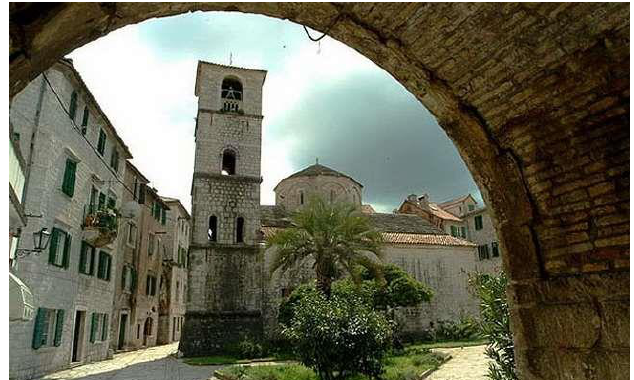
Figure 7. The Church of St. Mary dome is more solidly attached with the substructures, walls and lateral and transverse arches than the Cathedral of St. Tryphon.